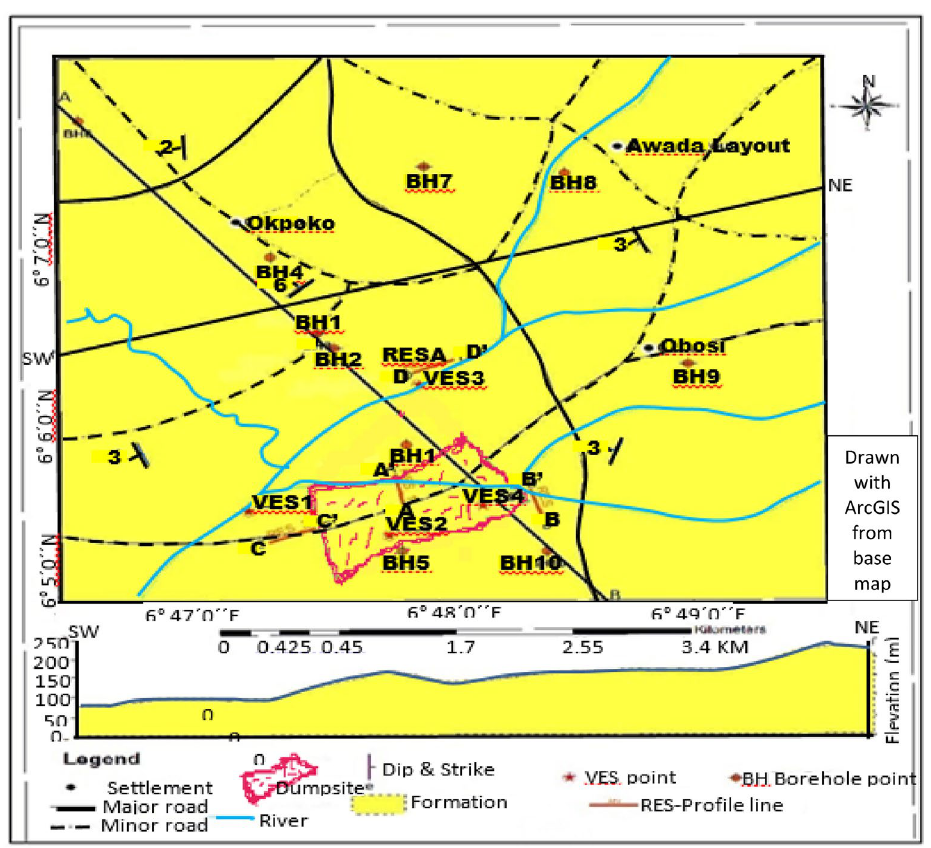
Figure 4. Geologic map of the study area showing the accessibility, drainage, topography and sampling points for VES, borehole and dumpsite, drawn from base map sourced from NGSA with ArcGIS